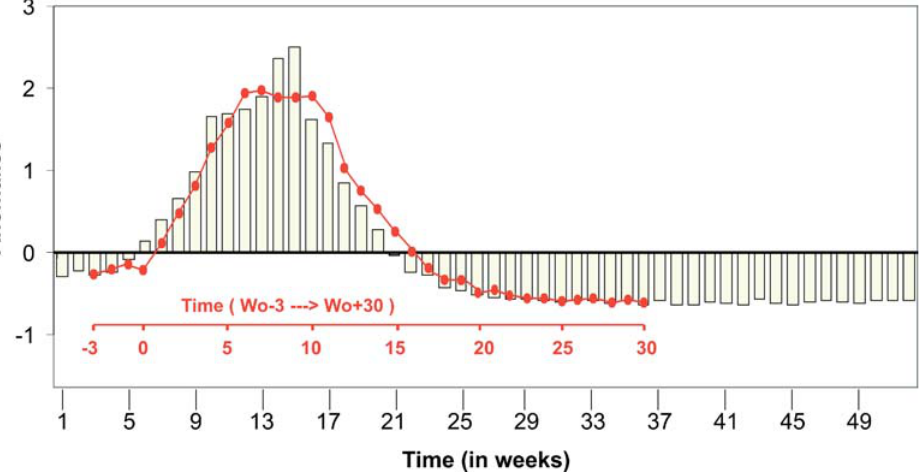
Figure 2. The Seasonal Periodicity of Meningitis Cases Mean seasonal pattern of the number of cases of MCM over the 1994–2002 period in standardized anomalies (bars). The red curve represents the same evolution, but in composite mean, using the week of epidemic onset as the reference date, W o , each year. Time series in red is shown